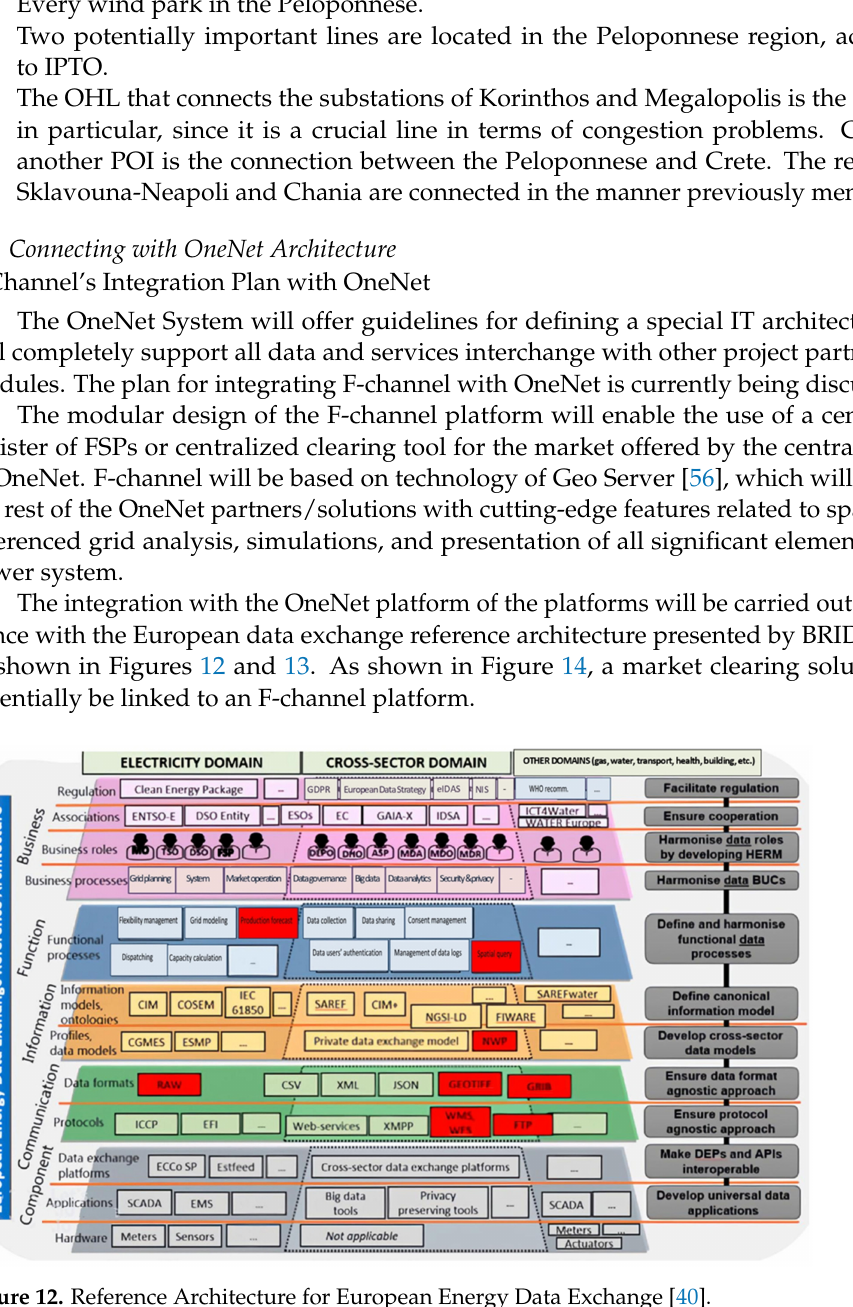
Figure 12. Reference Architecture for European Energy Data Exchange